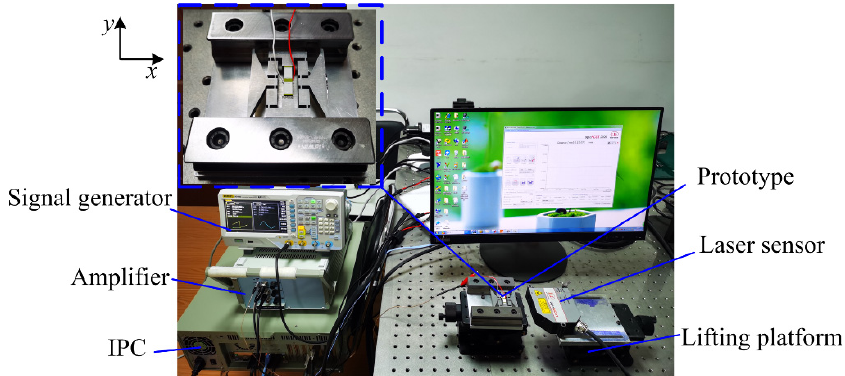
Figure 8. The established experimental